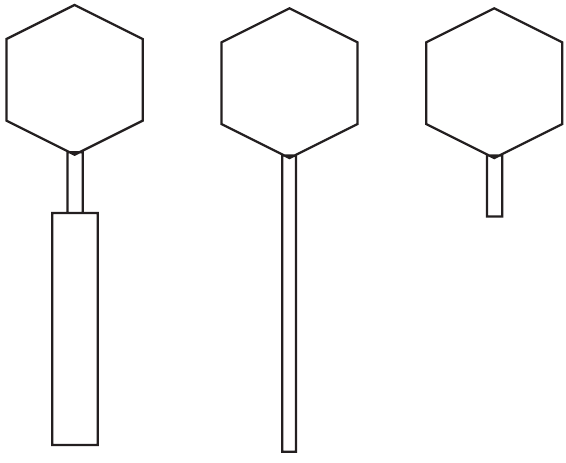
Figure 5: A diagram to show the three most common tailed bacteriophage morphotypes: Myoviridae (left), Siphoviridae (middle), and Podoviridae